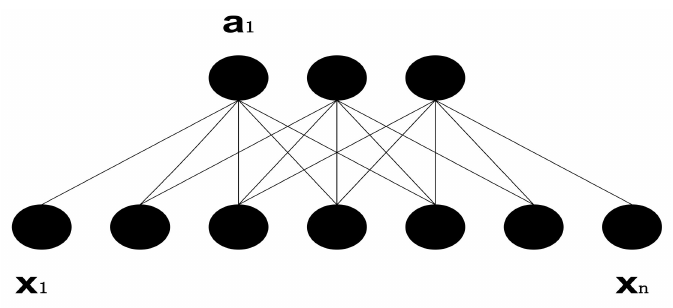
Figure 2. Sparse connection diagram of one-dimensional